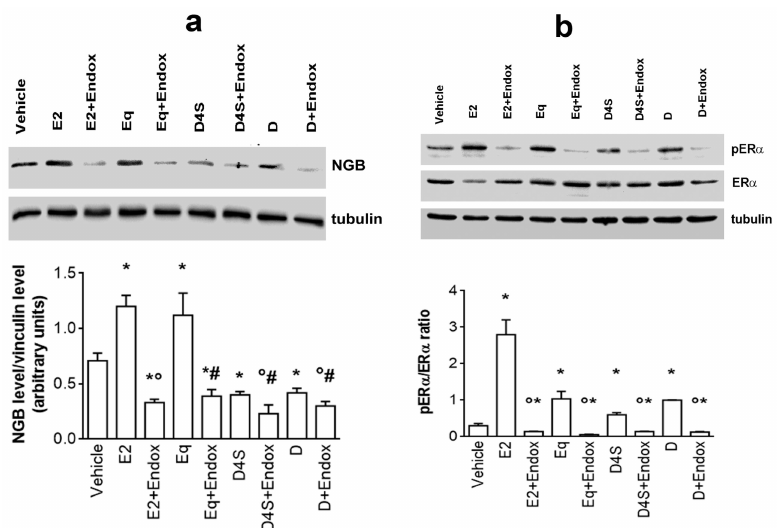
Figure 3. Daidzein, daidzein-4 (cid:48) -sulfate and equol e ff ect on ER α activation status. ( a ) Western blot (top) and densitometric analyses (bottom) of NGB protein levels in MCF-7 cells treated for 24 h with either vehicle (DMSO) or E2 (10 nM) or D, D4S and Eq (1 µ M) in presence or absence of the ER α inhibitor Endoxifen (1 µ M; 30 min pretreatment). The amount of proteins was normalized by comparison with tubulin levels. Data are the mean ± SD of three di ff erent experiments. p < 0.001 was determined with Student’s t test with respect to the vehicle (*) or E2-treated ( ◦ ) samples. ( b ) ER α activation by daidzein, daidzein-4 (cid:48) -sulfate and equol. The panel represents the ER α Ser118 phosphorylation status calculated as the ratio pER α / ER α ). Determined by Western blot analysis in MCF-7 cells exposed for 1h to either vehicle (DMSO) or E2 (10 nM) or D, D4S and Eq (1 µ M) in presence or absence of ER